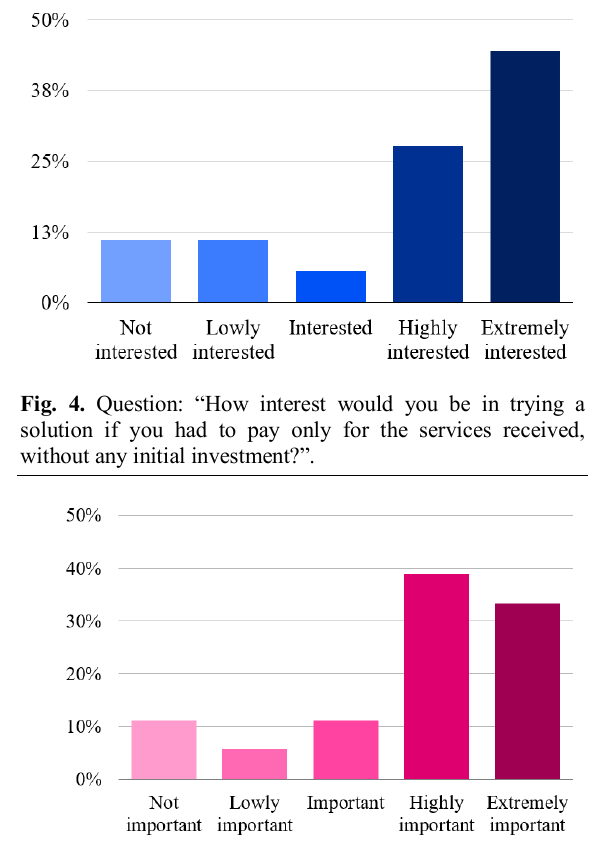
Fig. 5. Question: “How important is data management for you?”.